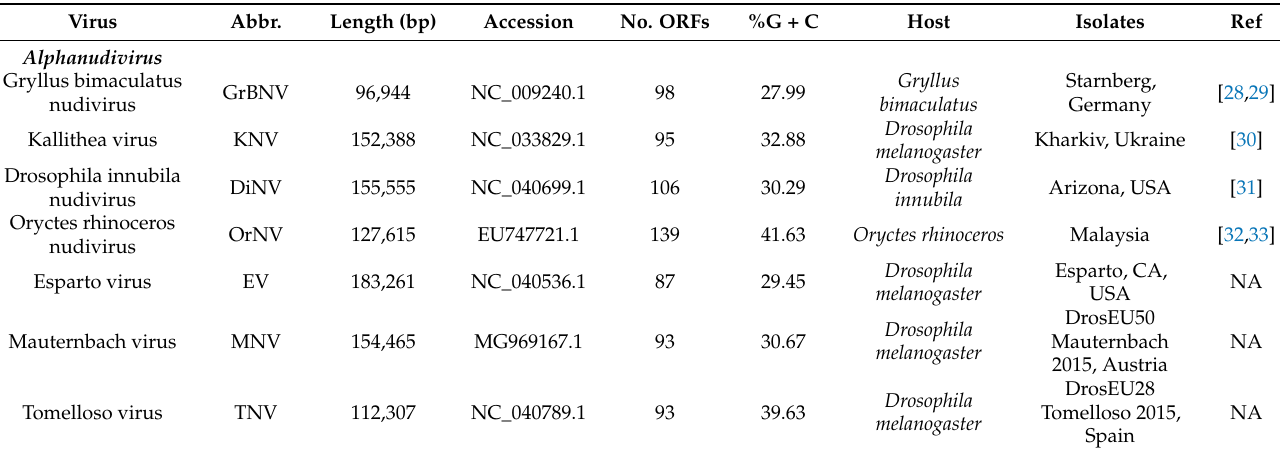
Table 1. Characteristics of exogenous nudivirus genome sequences (current as of December 2020). NA, not applicable. Virus